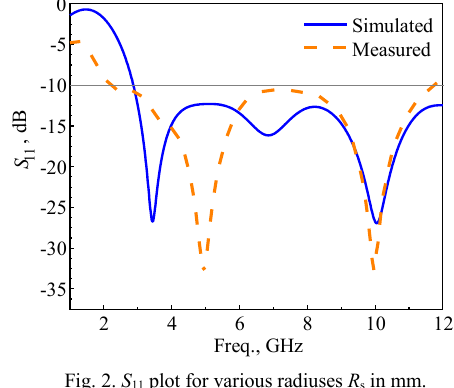
Fig. 2. S 11 plot for various radiuses R s in mm.